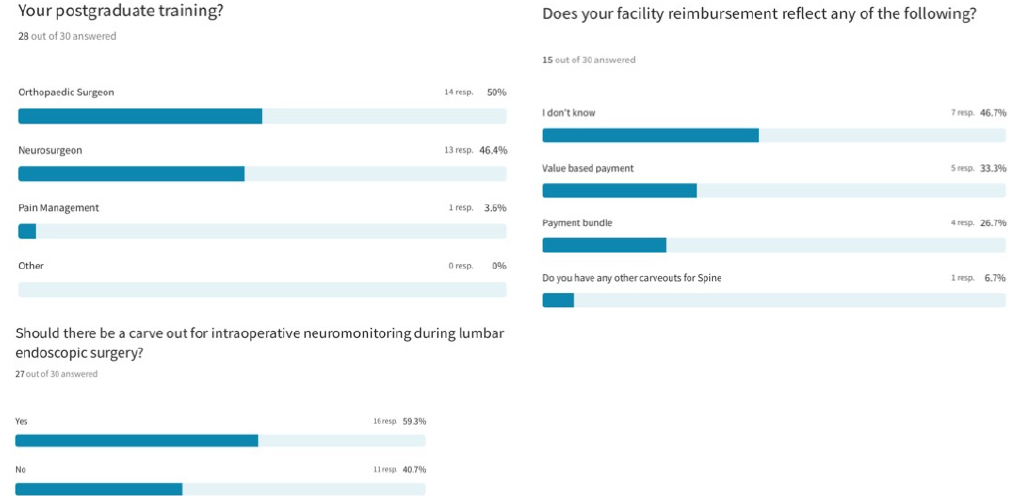
Figure 4. Most responding endoscopic spine surgeons had post-graduate subspecialty training in orthopedic surgery (50%), followed by neurosurgery (46.4%) and pain management (3.6%). Addi- tional carveouts for intra-operative neuromonitoring during awake lumbar endoscopic surgery were recommended by 59.3% of responding surgeons. Regarding payment models, 46.7% of surgeons did not know what arrangement their healthcare facility had with the payors regarding reimbursement of endoscopic spine surgery. Value-based and bundled payment models were reported by 33.3% and 26.7% of surgeons, respectively.